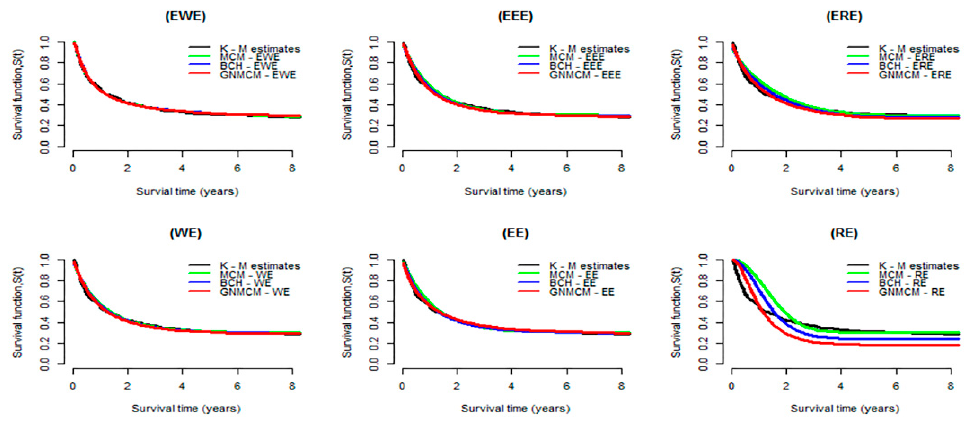
Figure 2. Estimated survival curves for the melanoma data obtained from the MCM, BCH and GNMCM based on the EWE distribution and its special cases. For comparison purpose, curves of Kaplan–Meier estimates are displayed in all plots.